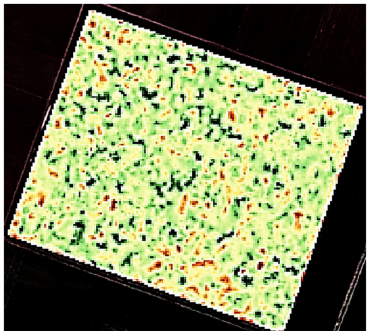
Figure 4. TGI index of 30 June 2020 for sugar beet to observe the presence of disease (black pixels mark potential infested